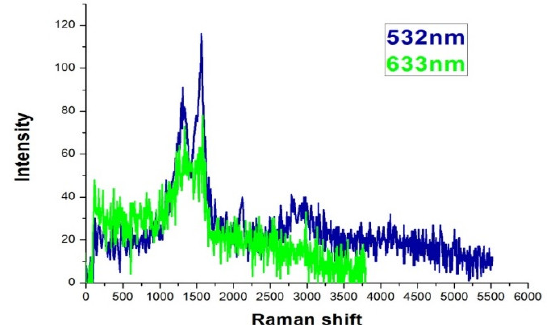
Figure 4. Raman spectra of a silver island film excited by 532 nm and 633 nm CW lasers. The exposure time was 10